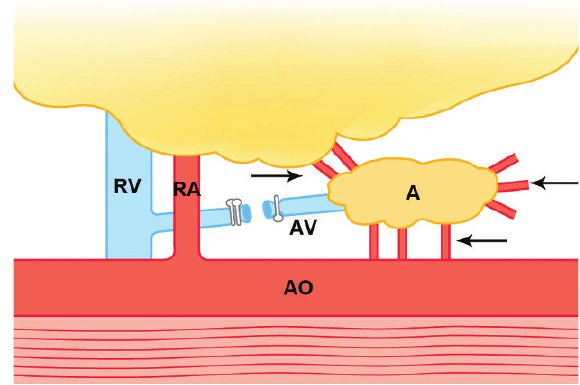
Figure 5 - Right-side retroperitoneoscopic adrenalectomy after adrenal vein section. Adrenal arteries indicated by the arrows. A: adrenal. AV: adrenal vein. IVC: inferior vena cava. P: psoas muscle.